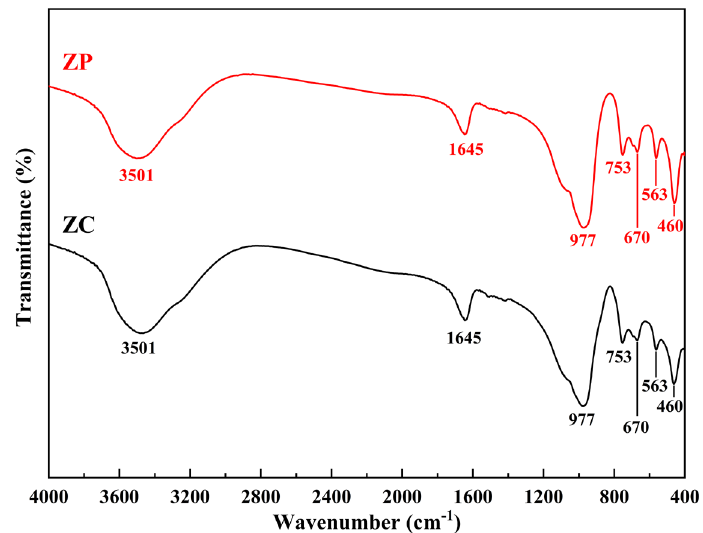
Figure 3. FTIR spectra of samples ZC and ZP.